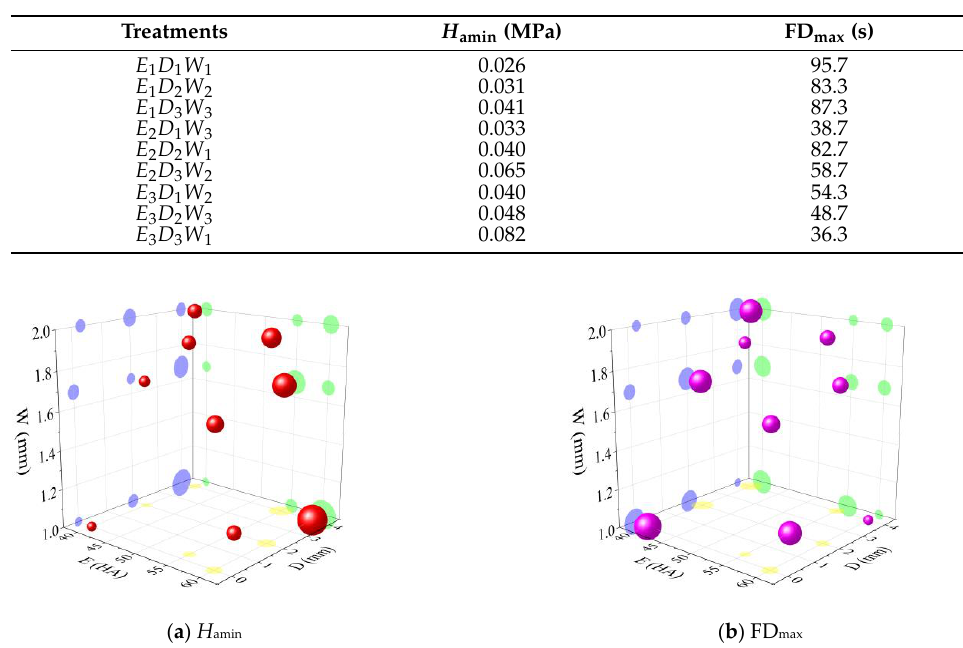
Table 2. Hydraulic performance experimental results for the AFVs.